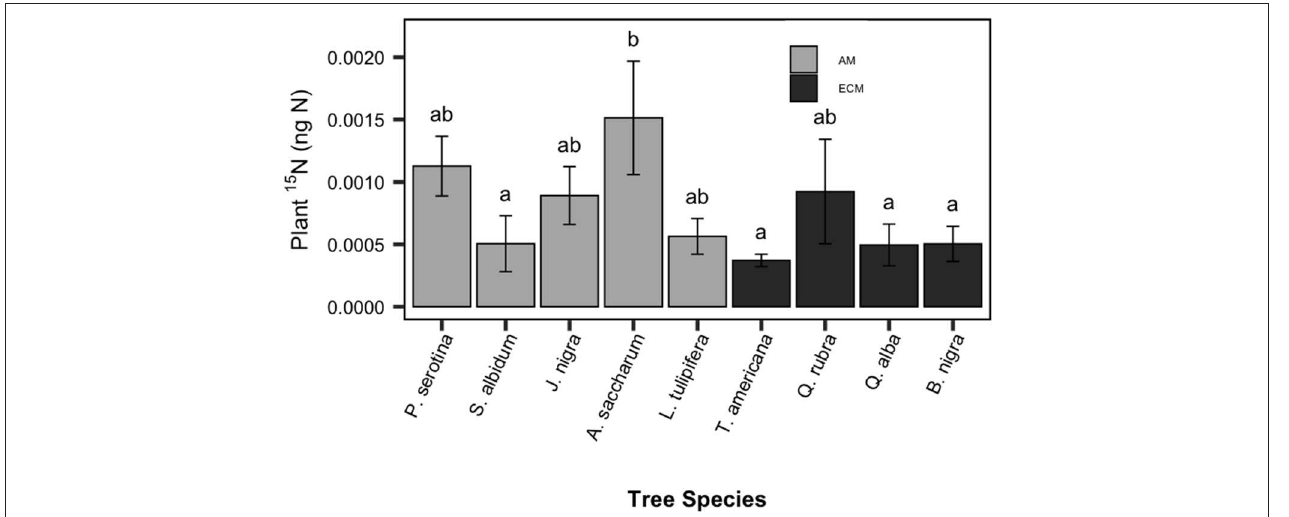
FIGURE 2 | Species patterns in sapling plant tissue 15 N enrichment, compared to saplings grown without 15 N-labeled particulate organic matter. Species means are shown with standard error bars. Light bars indicate AM-associated tree species, dark bars indicated ECM-associated species. Letters indicate significant pairwise differences ( P < 0.10).